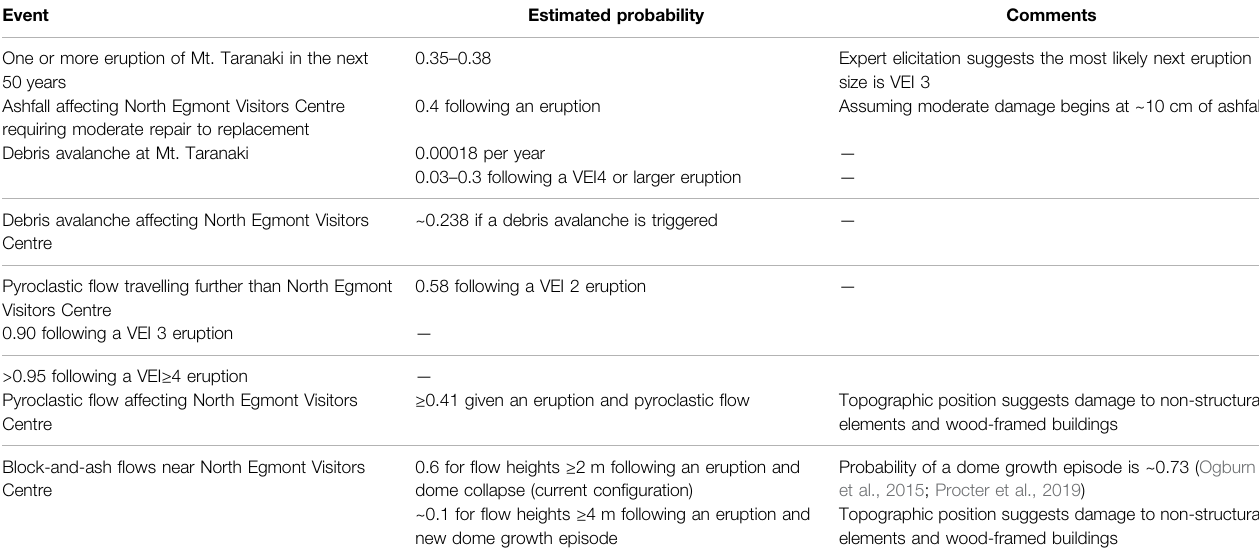
TABLE 4 | Summary of estimated probabilities for events at North Egmont Visitors